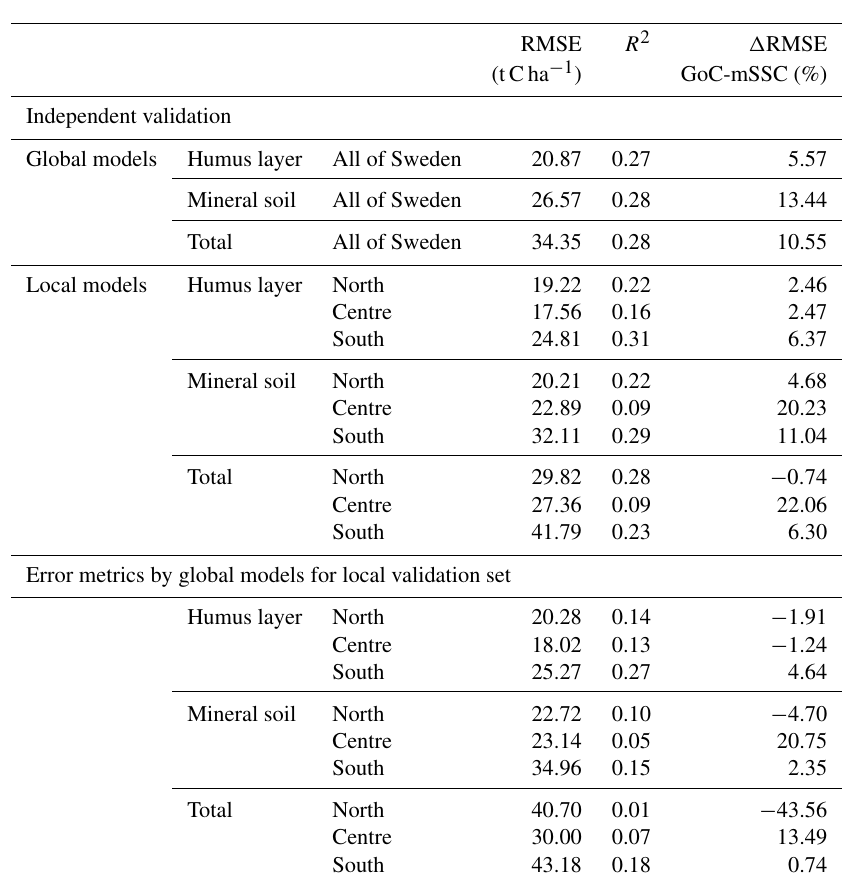
Table 6. Independent validation of the global and local random forest models based on the mapped site-specific covariates compared to models based on observed site-specific covariates and grouped of covariates. RMSE R 2 (cid:49) RMSE (tCha − 1 ) GoC-mSSC (%) Independent validation Global models Humus layer All of